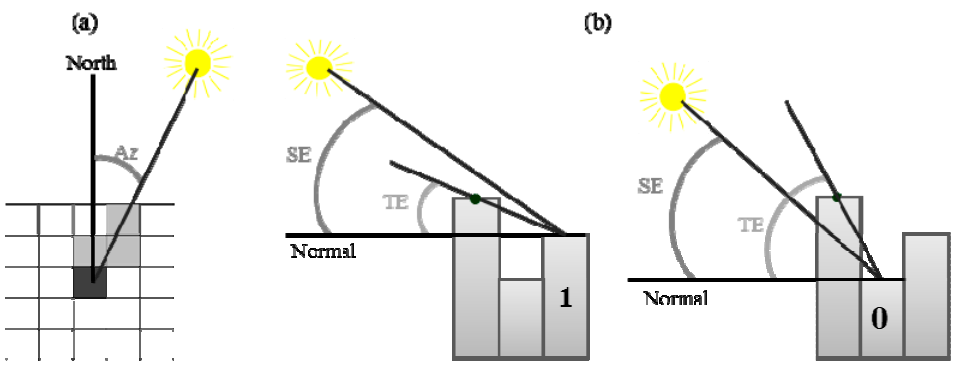
Figure 7. Shadow Binary Factor computation tests (Az = Azimuth angle, SE = Sun elevation angle, TE = Terrain elevation angle). ( a ) Identification of the pixels located on the path to the sun, ( b ) Test of shadowing effect of neighboring pixels according to the difference between terrain and sun elevation angles.